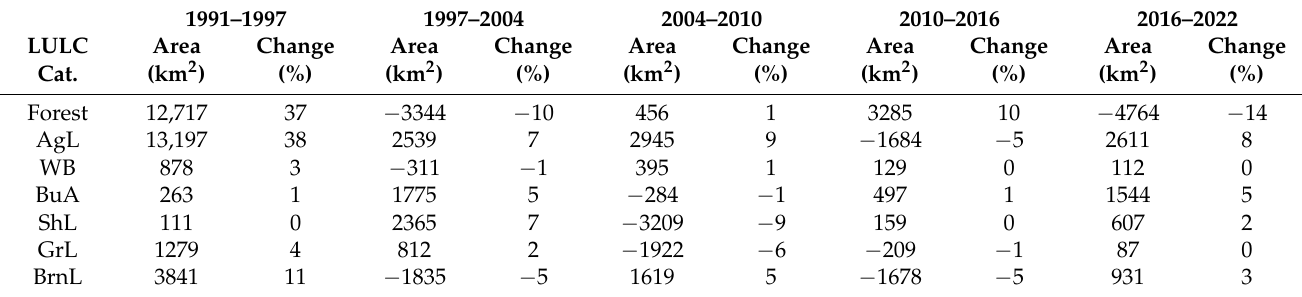
Table 6. LULC change analysis in 7-year intervals from 1991 to 2022.